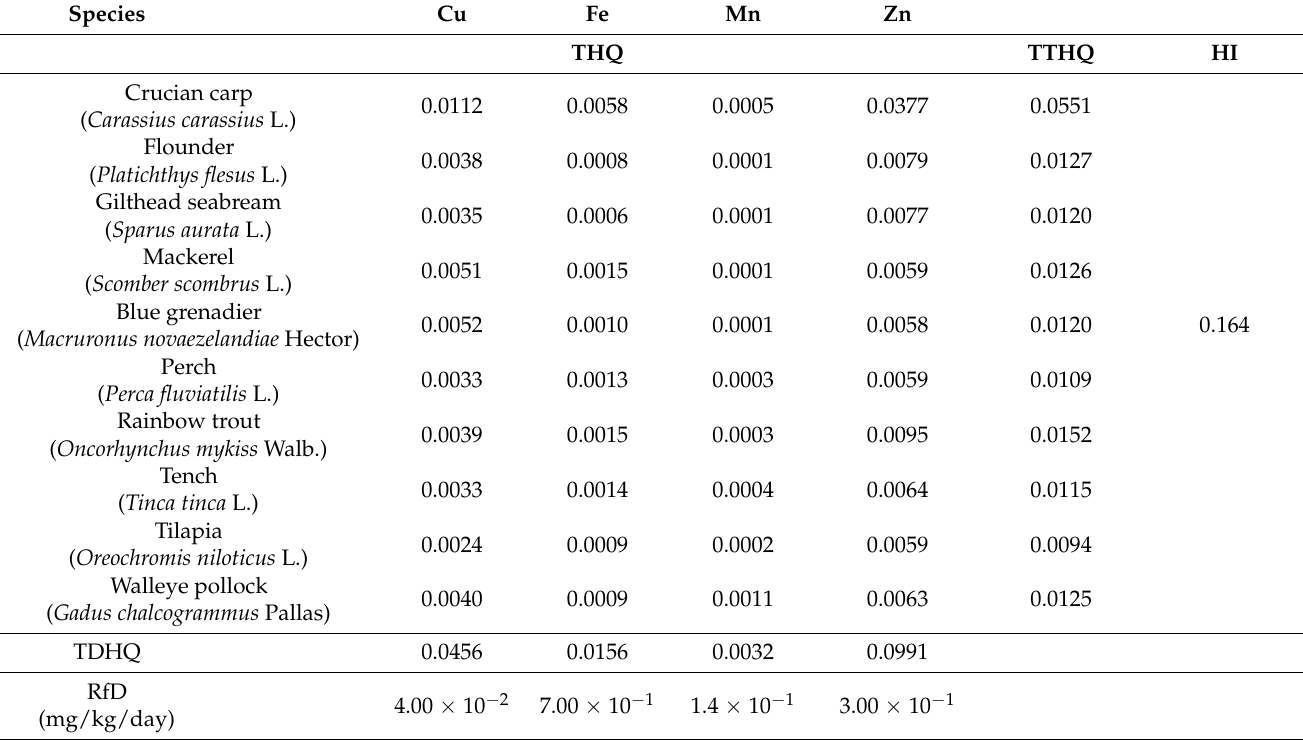
Table 3. The hazard quotient calculated for metal contents in the muscle tissues of